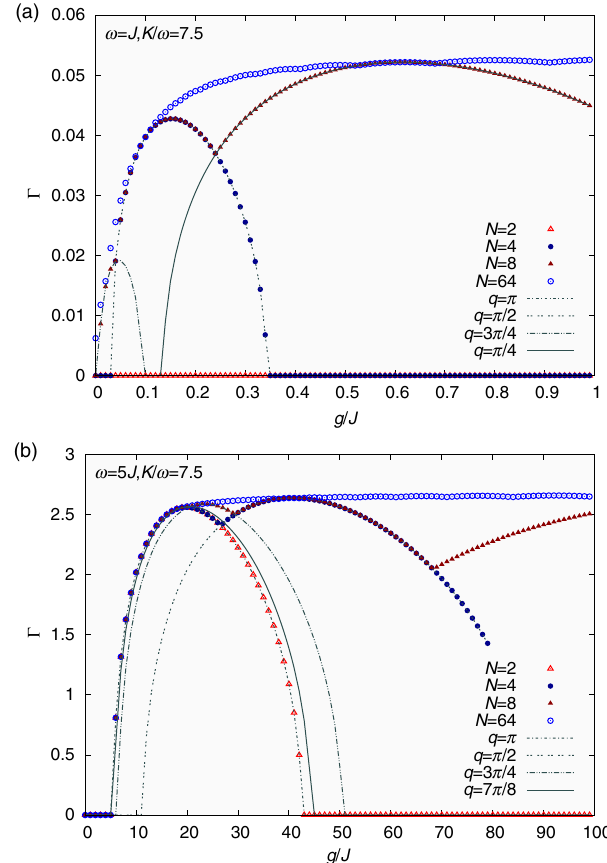
FIG. 9. Total instability rate and contributions of a few modes as a function of the interaction strength g , for ω ¼ J (low- frequency regime) and ω ¼ 5 J (outside the low-frequency regime), and for an increasing number of lattice sites N ¼ 2 , 4, 6, 64. The total instability rate is the envelope of the curves associated with “ available ” modes in the system (for N ¼ 2 , only q ¼ 0 , π ; for N ¼ 4 , only q ¼ 0 ; π = 2 ; π ; 3 π = 2 ...). The curve gets smoother when increasing the number of sites. Outside the low-frequency regime, the transition to instability is governed by the mode π and already captured by a two-site system. In the low-frequency regime, the instability rate at low g , which is governed by a certain mode q , is probed with more and more res accuracy when gradually increasing N : Here, the two-site > π , the four-site system system is always stable since q res > π = 2 , and then this transition displays a transition since q res lowers when probing q res